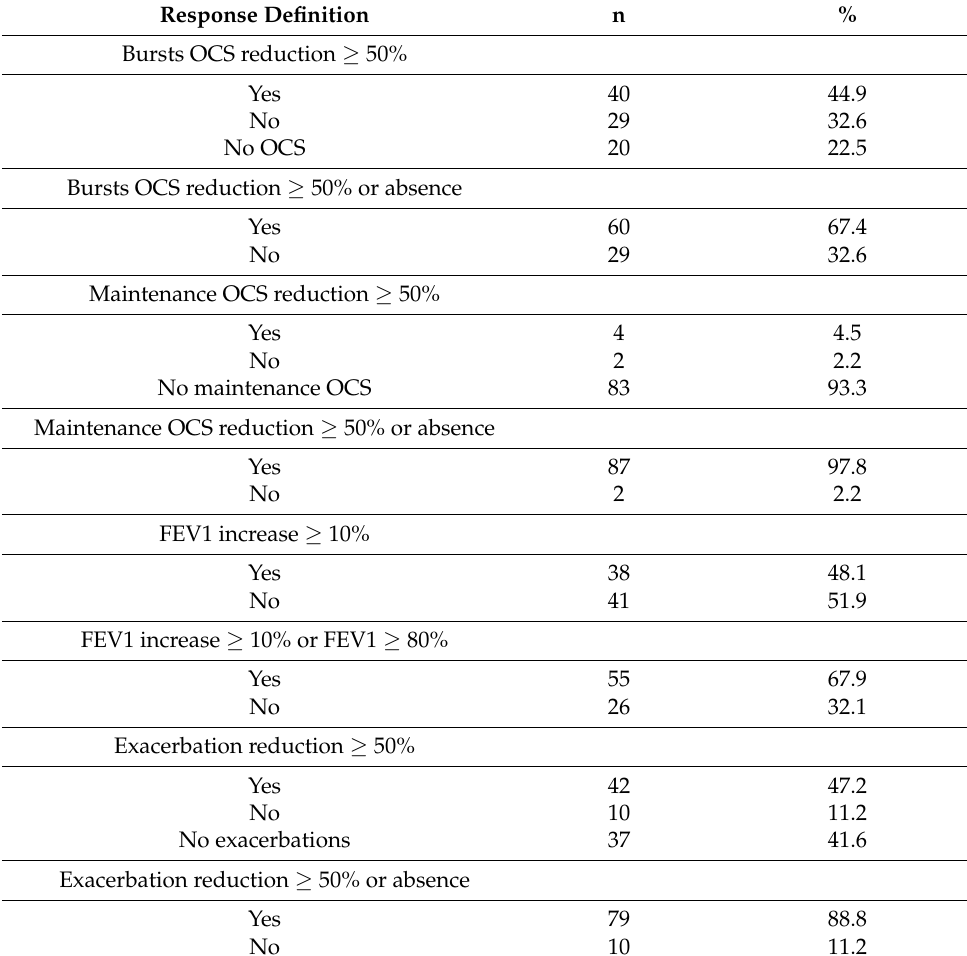
Table 4. Clinical effectiveness of mepolizumab in patients with severe uncontrolled asthma.